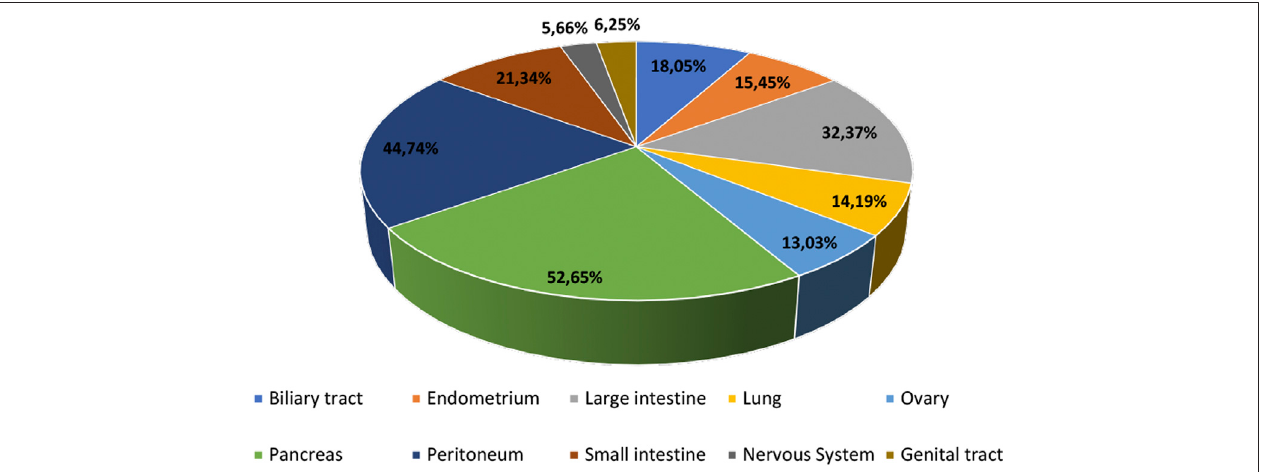
FIGURE 1 | Most frequent human tissues affected by K-RAS mutations based on the COSMIC database, v94 (data obtained in May 2021).